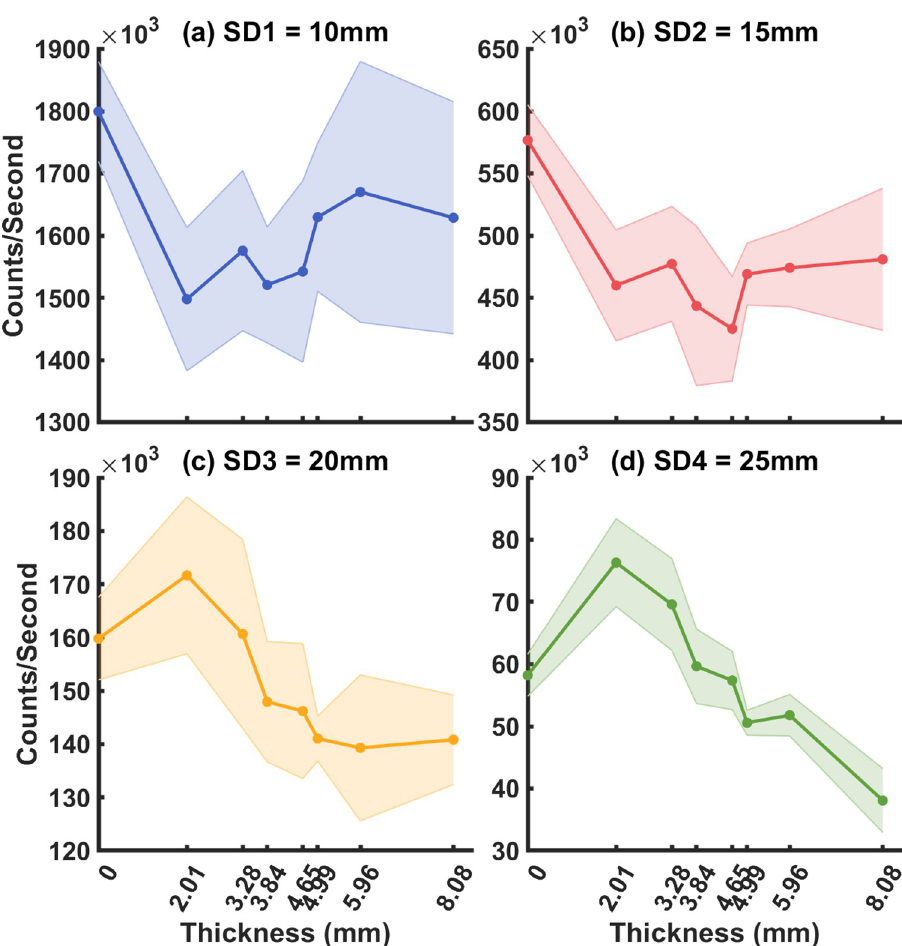
Fig 4. (a-d) Photon count rate vs. top layer thickness (P0-P7) for SD1-SD4 respectively. mm, and P7 = 8.08 mm at SD3 = 20 mm. The purple solid lines with shaded regions represent the mean and standard deviation of the measured g ; the green lines with circle and orange 1 lines represent the fitted g using two-layer and single-layer model (Eq (2)) respectively. We 1 can see that although the fitted g by the two-layer model did not describe the entire measured 1 g 1 accurately, it still performed better than the one-layer model by its ability to change the slope with different d . This is further quantified in terms of residuals as seen in Fig 6, where 1 the two-layer fit shows smaller residuals at longer delay times compared to the single layer fit.